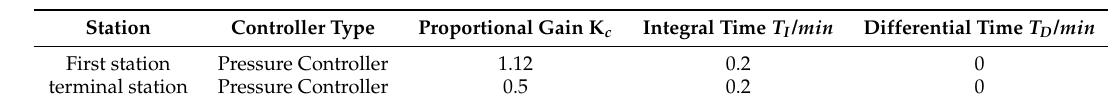
Figure 4. Steady state diagram. Table 1. Parameters of PID